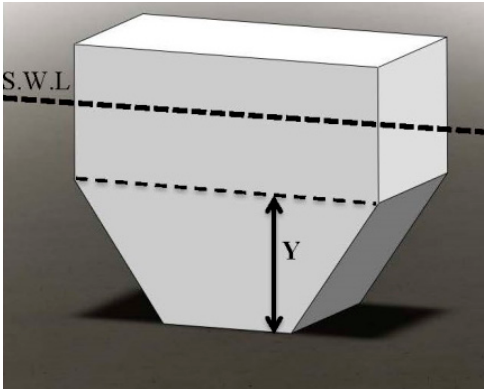
Figure 17. Description of the bottom cut shape.